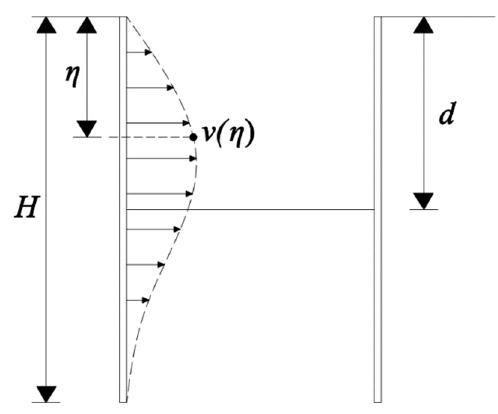
Figure 2. Deformation diagram of the sidewall retaining structure.